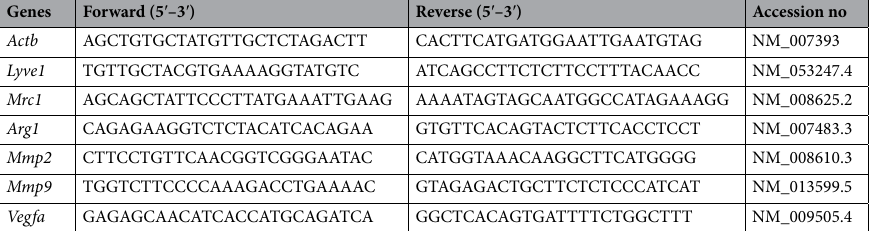
Staining was performed as described previously 51 . Briefly, for immunofluorescence staining of frozen samples, sections were incubated with primary antibodies overnight at 4 °C. The antibodies used were anti-LYVE-1 (11-036, rabbit monoclonal; AngioBio, San Diego, CA, USA), anti-CD68 (MCA341GA, mouse monoclonal; Bio-Rad, Kidlington, UK), anti-CD163 (MCA342GA, mouse monoclonal; Bio-Rad), anti-MHC-II (MCA46R, mouse monoclonal; Bio-Rad), and anti- CD146 (MAB3250, mouse monoclonal; R&D Systems, MN, USA). This was followed by 1-h incubation with Alexa Fluor 488-conjugated anti-mouse IgG (ab150065; Abcam, Cambridge, UK) and/or Alexa Fluor 568-con- jugated anti-rabbit IgG (ab175700; Abcam). Finally, nuclei were visualized by coverslipping with mounting media containing 4 ′ ,6 ′ -diamidino-2-phenylindole nuclear stain (DAPI, Aqueous; Flouroshield, Abcam). For cultured cells, 35-mm imaging dishes with a polymer coverslip bottom (Asahi Techno Glass, Shizuoka, Japan) were used for cell seeding. The cells were fixed with 4% paraformaldehyde and immunofluorescence stain- ing was performed as described above. Histological analyses were performed using a confocal laser scanning microscope (Leica TCS-SP8, Leica Microsystems; Wetzlar, Germany) and LAS AF confocal software (Version 1.8.3, Leica Microsystems). For immunoperoxidase staining, sections were fixed with 4% paraformaldehyde for 10 min at 4 °C. Endog- enous peroxidase activity was blocked by incubating the sections in 0.3% H 2 O 2 solution in PBS at room tem- perature for 10 min. The sections were incubated with an anti-LYVE-1 antibody (11-036; AngioBio) overnight at 4 °C, followed by 30-min incubation with biotinylated anti-rabbit IgG antibody (BA-1000; Vector Laborato- ries, Burlingame, CA, USA) and the avidin-biotin-peroxidase complex (R.T.U. Vectastain Universal ABC Kit, PK-7200; Vector Laboratories). The color reaction was performed using DAB substrate solution (ImmPACT DAB; Vector Laboratories). The sections were counterstained using methyl green (MUTO, Tokyo, Japan) and mounted using mounting medium (VectaMount; Vector Laboratories). Histology was observed under light microscopy (Axio Vert; Zeiss). Plasmid transfection. RAW264.7 cells were transfected with a Lyve1 overexpression vector (Lyve1_ pcDNA3.1+/C-(K)DYK; Clone ID OMu20286, GenScript, Piscataway, NJ, USA) using FuGENE HD (Promega, Madison, WI, USA) to generate Lyve1 -expressing macrophages. All steps were performed in accordance to the manufacturer’s instructions. Briefly, RAW264.7 cells (2 × 10 5 cells/ml) were seeded in 24-well plates 1day before transfection. FuGENE/pcDNA3.1.LYVE-1 complex mixture at a ratio of 3:1 was freshly prepared containing 0.5 μg expression vector. The mixture was added to the wells and the plates were incubated under standard con- ditions (37 °C, 5% CO 2 ) for 24 h. Cells transfected with an enhanced green fluorescent protein (EGFP) expres- sion vector (pMAX-EGFP; Lonza) were used as a control. LPS stimulation and M2 macrophage polarization. For LPS stimulation, Lyve1 -expressing mac- rophages were cultured with or without LPS (100 ng/ml; Escherichia coli O111B4; Merck, Kenilworth, NJ, USA) for 4 h. For M2 macrophage polarization, RAW264.7 cells were seeded at a low density of 10 4 cells/ml in 6-well plates followed by 7 days’ incubation in DMEM supplemented with 10% heat-inactivated FBS and MID, a mix- ture of M-CSF (100 ng/m; BioLegend, San Diego, CA, USA), IL-4 (10 ng/ml; PeproTech, East Windsor, NJ, USA), and dexamethasone (1000 U/ml; Wako Pure Chemical Industries). Culture medium was exchanged every 2 days. Preparation of conditioned media. RAW246.7 cells (10 5 cells/ml) were seeded on 60-mm culture plates and transfected with Lyve1 overexpression vector as described above. One day after transfection, the cells were washed thoroughly using PBS and replenished with serum-free EBM-2 for 24 h under standard conditions (37 °C, 5% CO 2 ). Conditioned media from Lyve1 -expressing macrophages (CM-L) or RAW246.7 cells (CM-R) were collected, centrifuged at 3000 rpm for 5 min at 4 °C to remove cell debris and stored at − 30 °C. Reverse transcription‑quantitative polymerase chain reaction. Total RNA was extracted using a QuickGene RNA cultured cell kit S (Wako Pure Chemical Industries), and cDNA (300 ng) was synthesized using PrimeScript™ RT Master Mix (Takara Bio, Kusatsu, Japan). For reverse transcription-quantitative polymerase chain reaction (RT-qPCR), template cDNA was amplified with GoTaq qPCR Master Mix (Promega) using a CFX96 Real-Time qPCR System (Bio-Rad). For normalization of the template amount, gene expression was calculated in relation to Actb as a housekeeping gene. Specific primers are listed in Table 1.